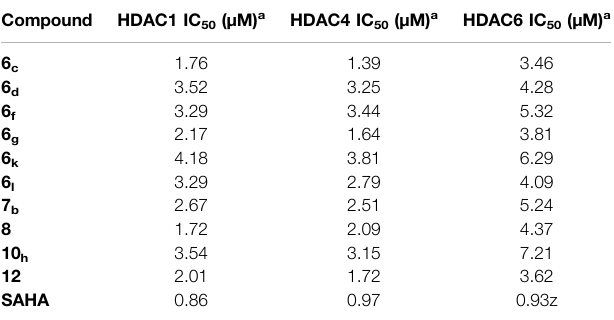
TABLE 2 | Effect of conjugates ( 6 c , 6 d , 6 f , 6 g , 6 k , 6 l , 7 b , 8 , 10 h , and 12 ) as HDAC